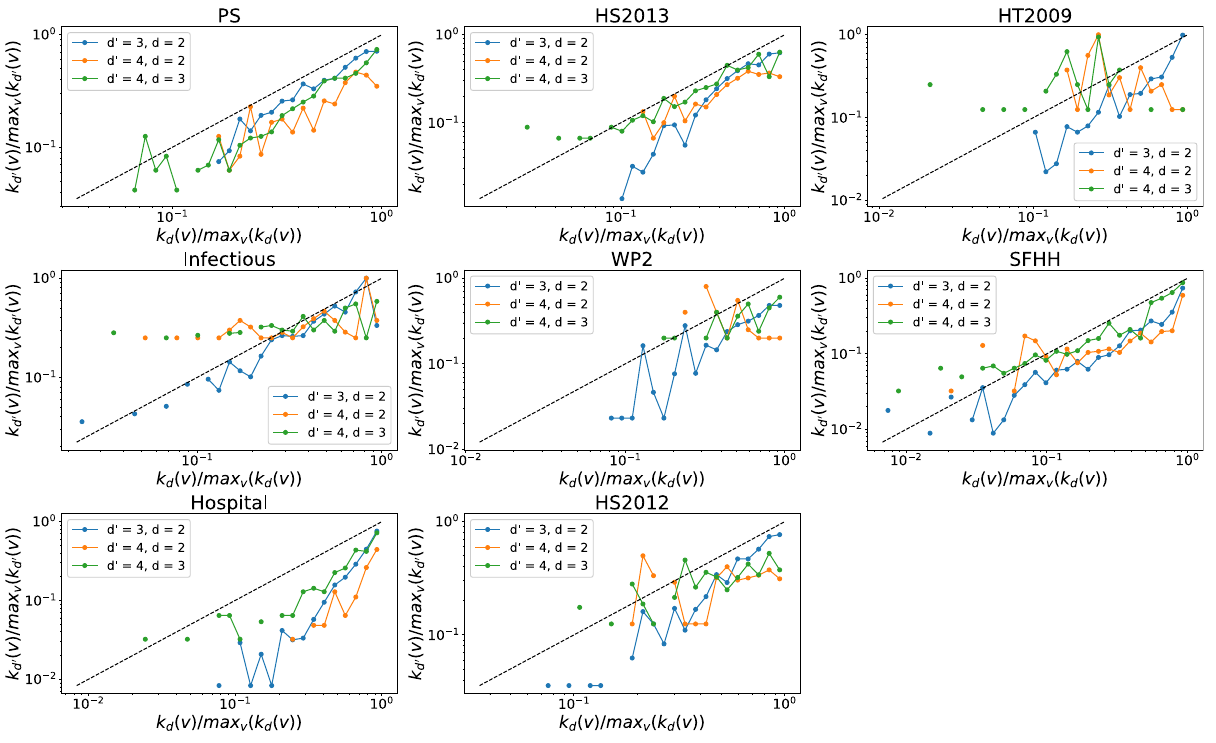
Figure 5. The d ′ -degree k d ′ ( v ) versus the the d -degree k d ( v ) of a node v when ( d ′ , d ) is equal to (3,2) (blue line), (4,2) (yellow line) and (4,3) (green line) respectively in each physical contact network. Each axis (e.g., k d ( v ) ) has been normalized by its maximum (e.g., max v ( k d ( v )) ). Only nodes whose d -degree and d ′ -degree are both non-zero are considered. The dashed line represent the reference case axes are presented in logarithmic scales. In total 30 logarithmic bins are split for horizontal axis.